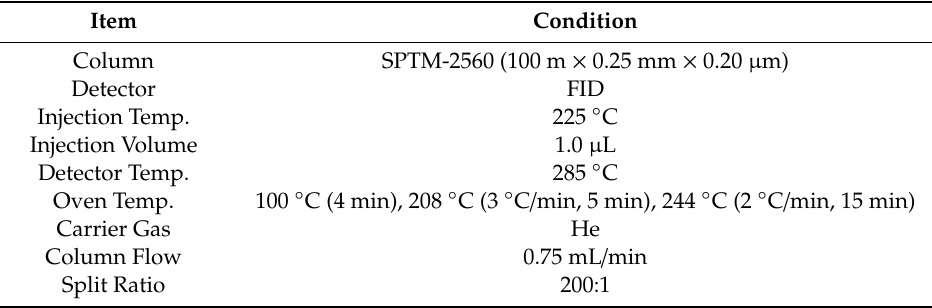
Table 2. Analysis